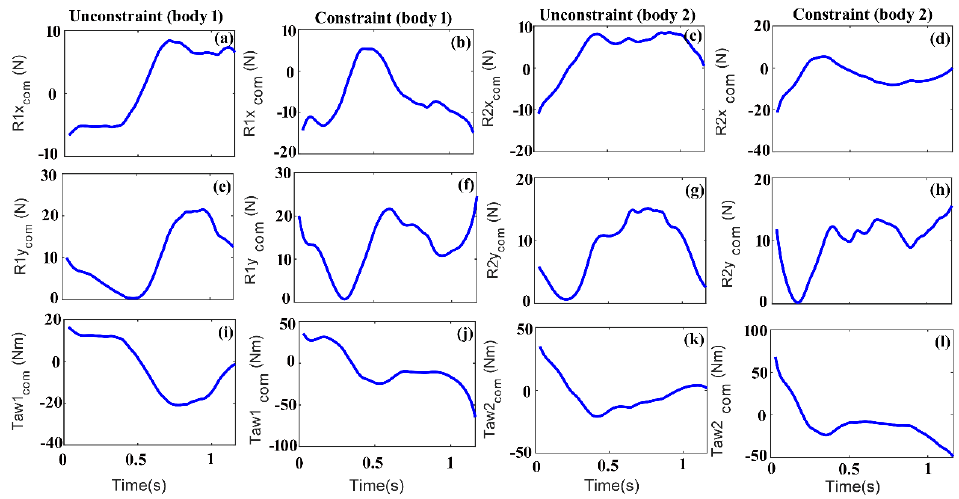
Figure 5. Aerodynamic ( a – d ) X forces, ( e – h ) Y forces, and ( i – l ) momentums of the unconstrained and constrained mechanisms, bodies 1 and 2.